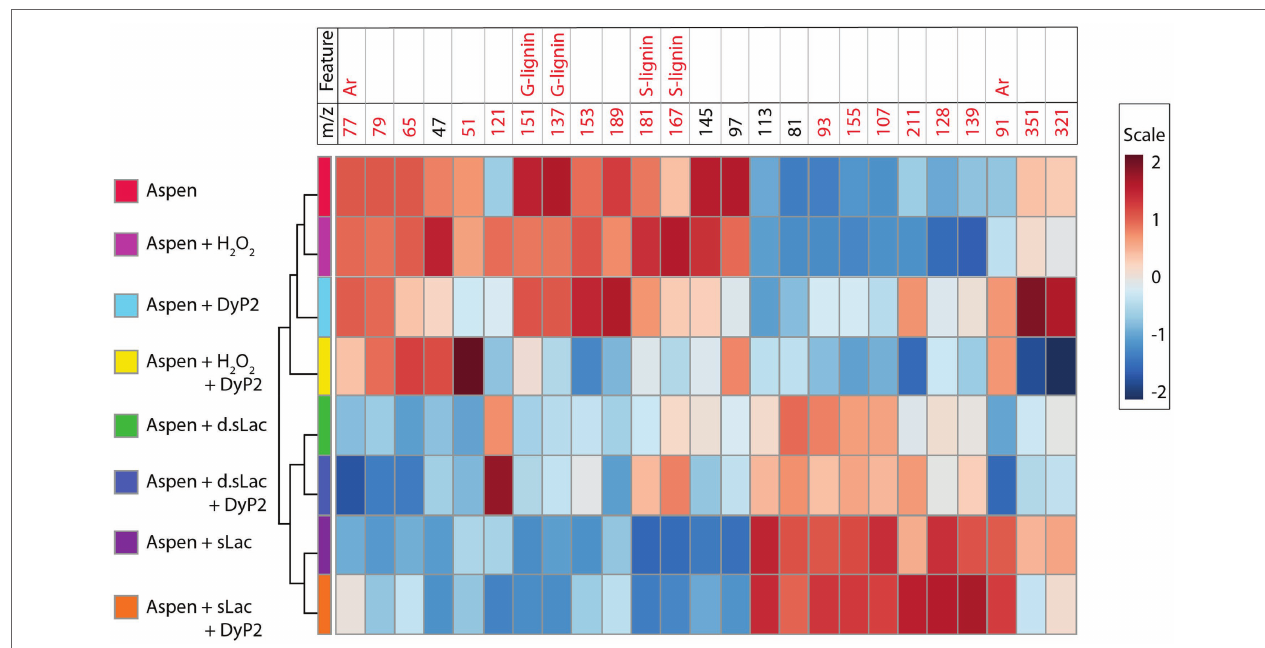
FIGURE 7 | Hierarchical clustering heatmap of aspen wood powder treated with different enzymes. Samples (average of six acquisition data) are in columns. sLac and DyP2, 0.2 mg/ml each, were added to individual or mixture treatments. Heat-denatured sLac (d.sLac) was included as a control of sLac. The top 25 ToF-SIMS peaks, ranked by t -test/ANOVA, are shown in columns; the m/z values for lignin are written in red while m/z values for polysaccharides are written in black. Feature peaks for G-lignin, S-lignin, and aromatic rings (Ar) (Saito et al., 2005) are